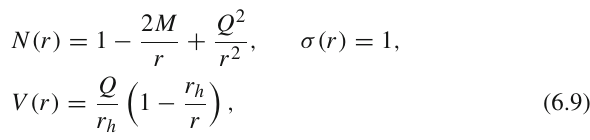
tial (cid:17) ( i . e . in a grand canonical ensemble) exist from an arbitrary small size up to a maximal BH size, as specified by the event horizon area A H . This defines the fundamen- tal branch . Along this fundamental branch, both the mass and the electric charge increase with A H . At the same time, the value of the scalar field at the horizon decreases—Fig. 4 ( max ) , a secondary branch (left panel). As A H → A H